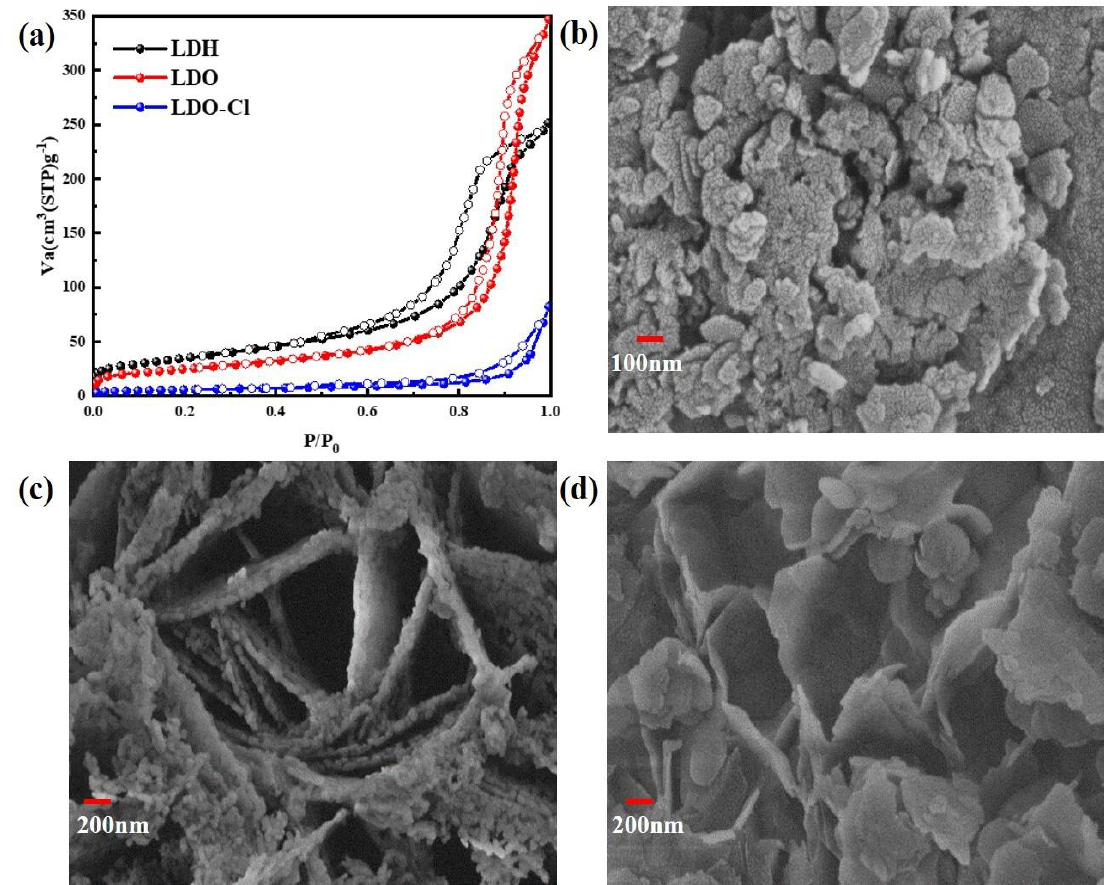
Figure 11. ( a ) N 2 adsorption − desorption isotherms; ( b − d ) SEM images of the samples.